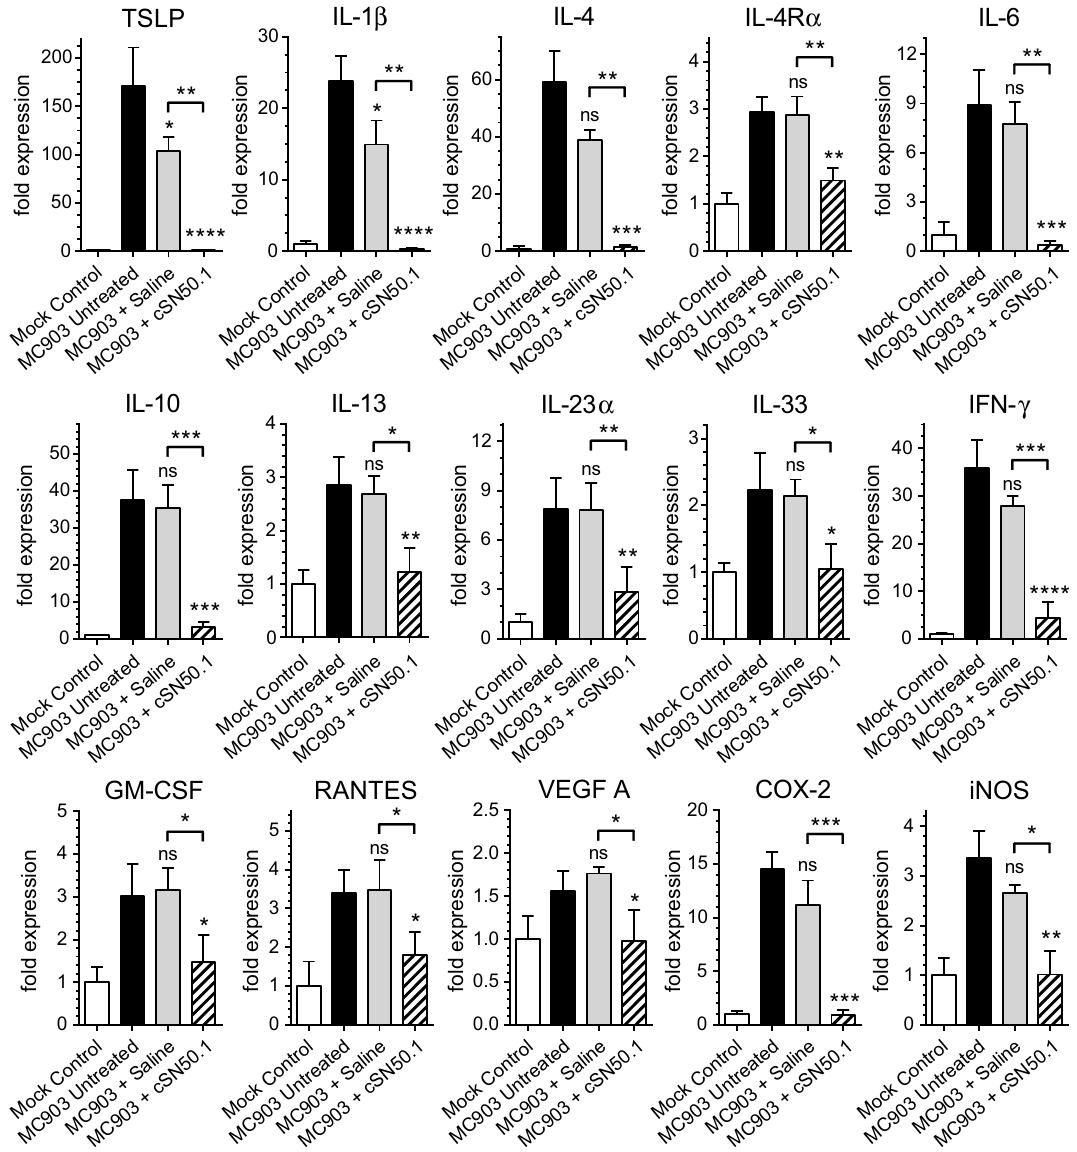
Figure 3. The expression of genes encoding the mediators of skin inflammation is suppressed by NTCI. The expression of genes encoding the mediators of allergic inflammation in the ear samples (see Methods and Fig. 1 for a depiction of AD-like phenotype induction and treatment protocol) was determined using a real-time quantitative reverse transcription PCR (qRT PCR). The relative levels of expression were established using Livak’s methods (2 −∆∆Ct ) with the 18S gene as a reference and the Mock Control (unchallenged ear) group as the calibrator. Data is presented as a mean + S.E.M. (n = 3 for Mock Control, n = 5 for all other conditions). A statistical analysis was performed using an ordinary one-way ANOVA with an uncorrected Fisher’s LSD test for a multiple comparison, * p < 0.05, ** p < 0.005, *** p < 0.0005. The significance levels displayed over the bars of MC903 + Saline and MC903 + cSN50.1 columns represent the statistical difference of each compared to MC903 Untreated